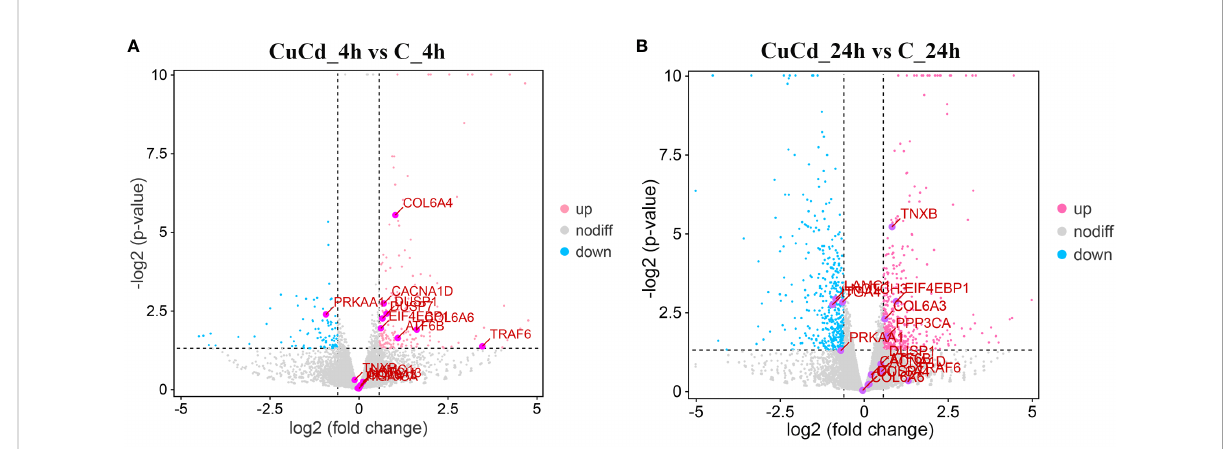
FIGURE 1 DEGs expression distributions. (A) DEGs expression distributions between CuCd_4h and C_4h. Up-regulated DEGs are represented as pink dots; down-regulated DEGs are expressed as blue dots; and non-regulated DEGs are indicated by grey dots. (B) DEGs expression distributions between CuCd_24h and